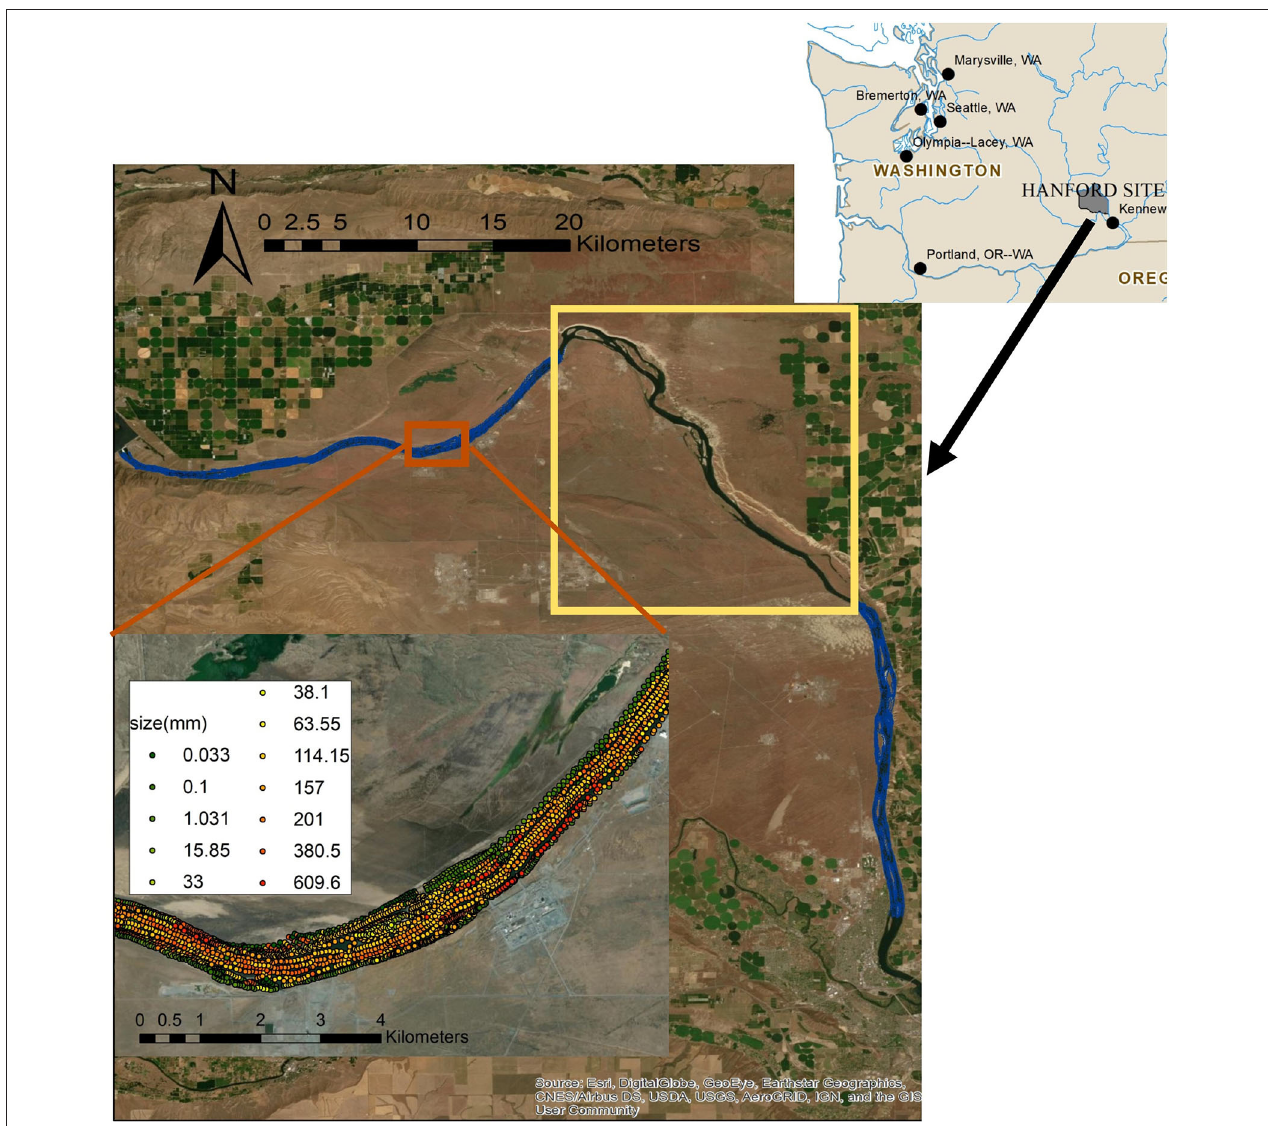
FIGURE 1 | The location of substrate size samples along the Hanford Reach of the Columbia River. The blue dots are the sampling locations and the yellow box is the region without samples. The enlarged subplot shows the substrate size